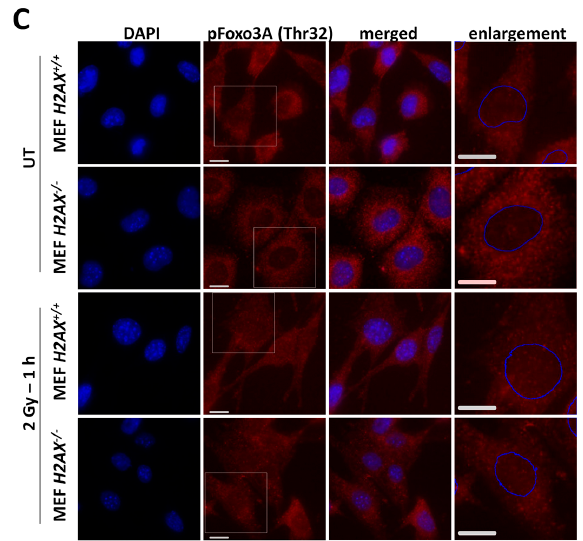
Figure 4. FoxO3a is differentially regulated and localized in H2AX + / + and H2AX − / − MEF cells. ( A ) Representative microphotographs of untreated and γ -irradiated cells showing cytoplasmic and nuclear localization of FoxO3a (red), pATM (Ser1981) (green), as well as foci formation and the two protein co-localization after irradiation in H2AX + / + but not H2AX − / − cells. Enlarged areas are identified by a white box and shown on the right of each channel.. Nuclei were counterstained with DAPI (blue); scale bar, 10 m; ( B ) Representative Western blot images of pFoxO3a (Thr32) and FoxO3a obtained from whole cell protein lysates of untreated MEF H2AX + / + and H2AX − / − cells or 1 h after irradiation with indicated doses of γ -radiation. Ponceau and b-actin were used to control for equal loading; ( C ) Representative microphotographs of untreated H2AX + / + and H2AX − / − MEF cells immunostained for pFoxO3A (Thr32) (red). Nuclei were counterstained with DAPI (blue). Enlarged areas are identified by white boxes and shown on the right. Nuclear perimeters on the enlargements are shown as blue circles to allow for nuclear vs. cytoplasmic visualization of pFoxO3a (Thr32); scale bar, 10 m; ( D ) Quantification of cytoplasmic and nuclear levels of pFoxO3a (Thr32) in MEF H2AX + / + and H2AX − / − cells expressed as arbitrary units (grey scale values) per cell. * and ** denote statistically significant difference between H2AX − / − and H2AX + / + cells with p < 0.05 and p < 0.01, respectively, using Student’s t -test ( n = 200 cells). Data represent results from three independent experiments.